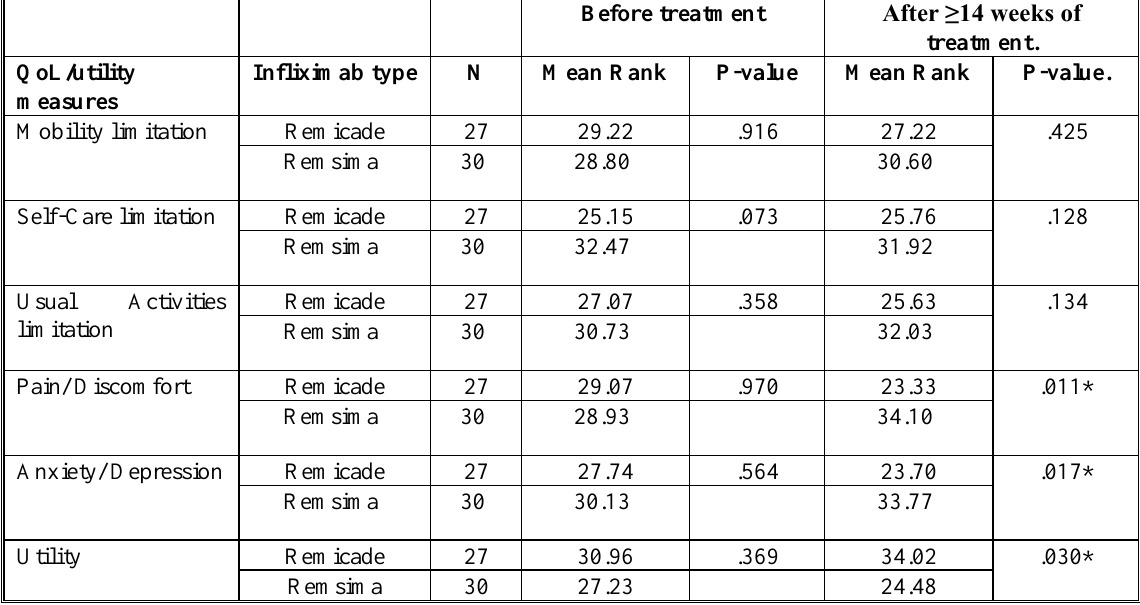
Table 4. The difference in the quality-of-life dimensions and utility measures between the groups before treatment and at least 14 weeks after treatment.